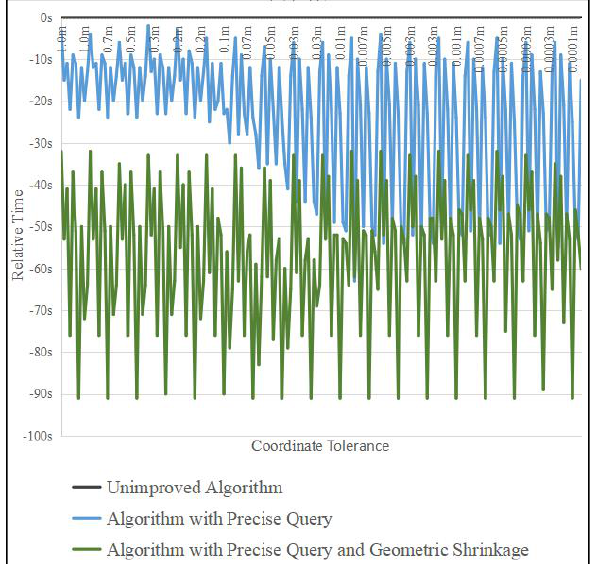
Figure 5. Processing time of all samples of farmland data